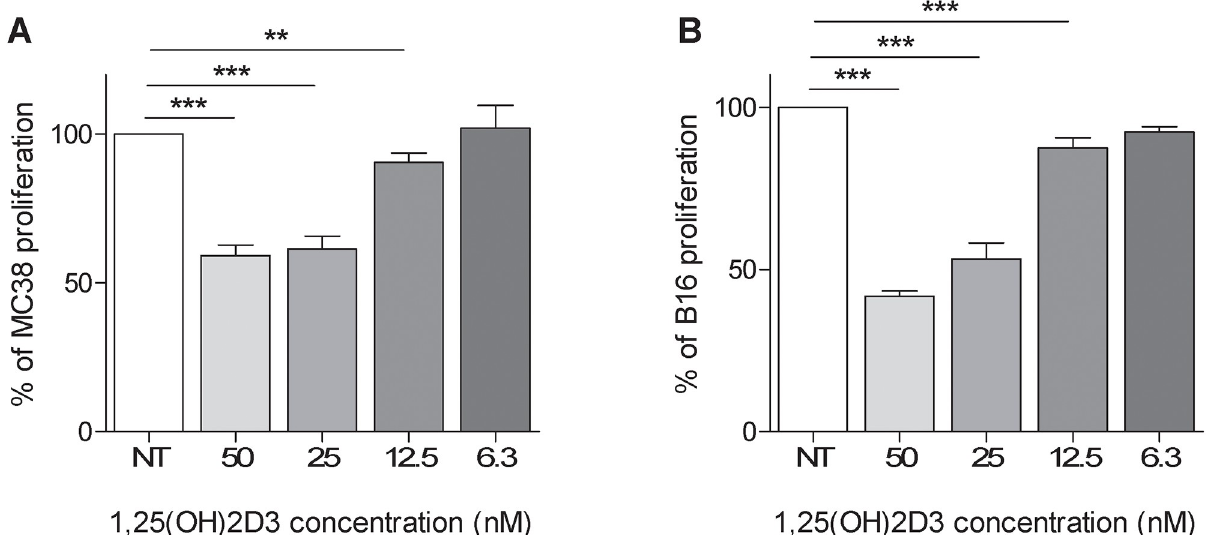
Fig 3. Anti-proliferative in vitro activity of 1,25(OH)2D3 against cancer cells. MC-38 colon cancer cell (A) and B16 melanoma cells (B) were exposed to different concentration of 1,25(OH)2D3 for 72 h. Cells proliferation was evaluated by SRB assay at the end of the experiment as the optical density (OD) of 1,25(OH)2D3-treated cells/ the optical density (OD) of 1,25(OH)2D3-untreated cells � 100; bars represent the mean of cells proliferation ± SD; Unpaired t test �� p < 0.005; ��� p < 0.0001.